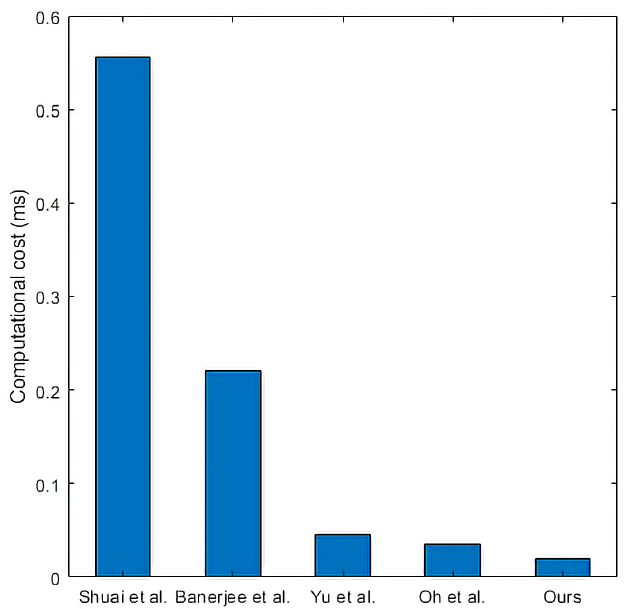
Figure 8. The computational cost of EGW. Shuai et al. [37], Banerjee et al. [40], Yu et al. [18], and Oh et al.